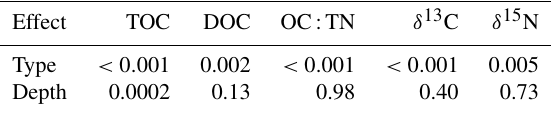
Table 1. The significance of effects of type and depth to bulk TOC, porewater DOC, bulk OC / TN ratio δ 13 C, and δ 15 N using ANOVA on the basis of the generalized additive model (GAM). In the pa- rameter of depth, the approximate significance of smooth term is